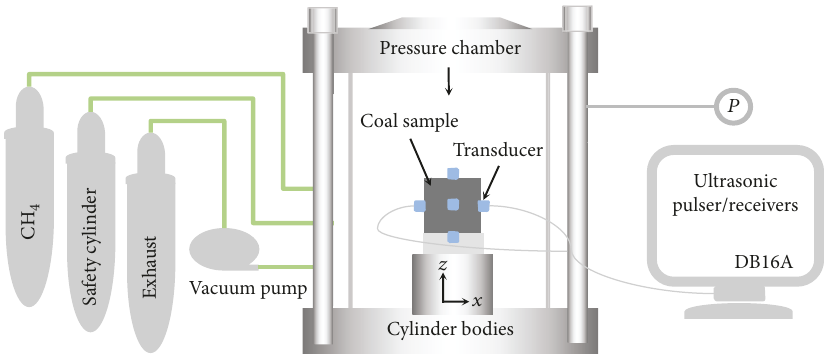
Figure 3: Ultrasound anisotropy testing system of coal samples (simpli fi ed).